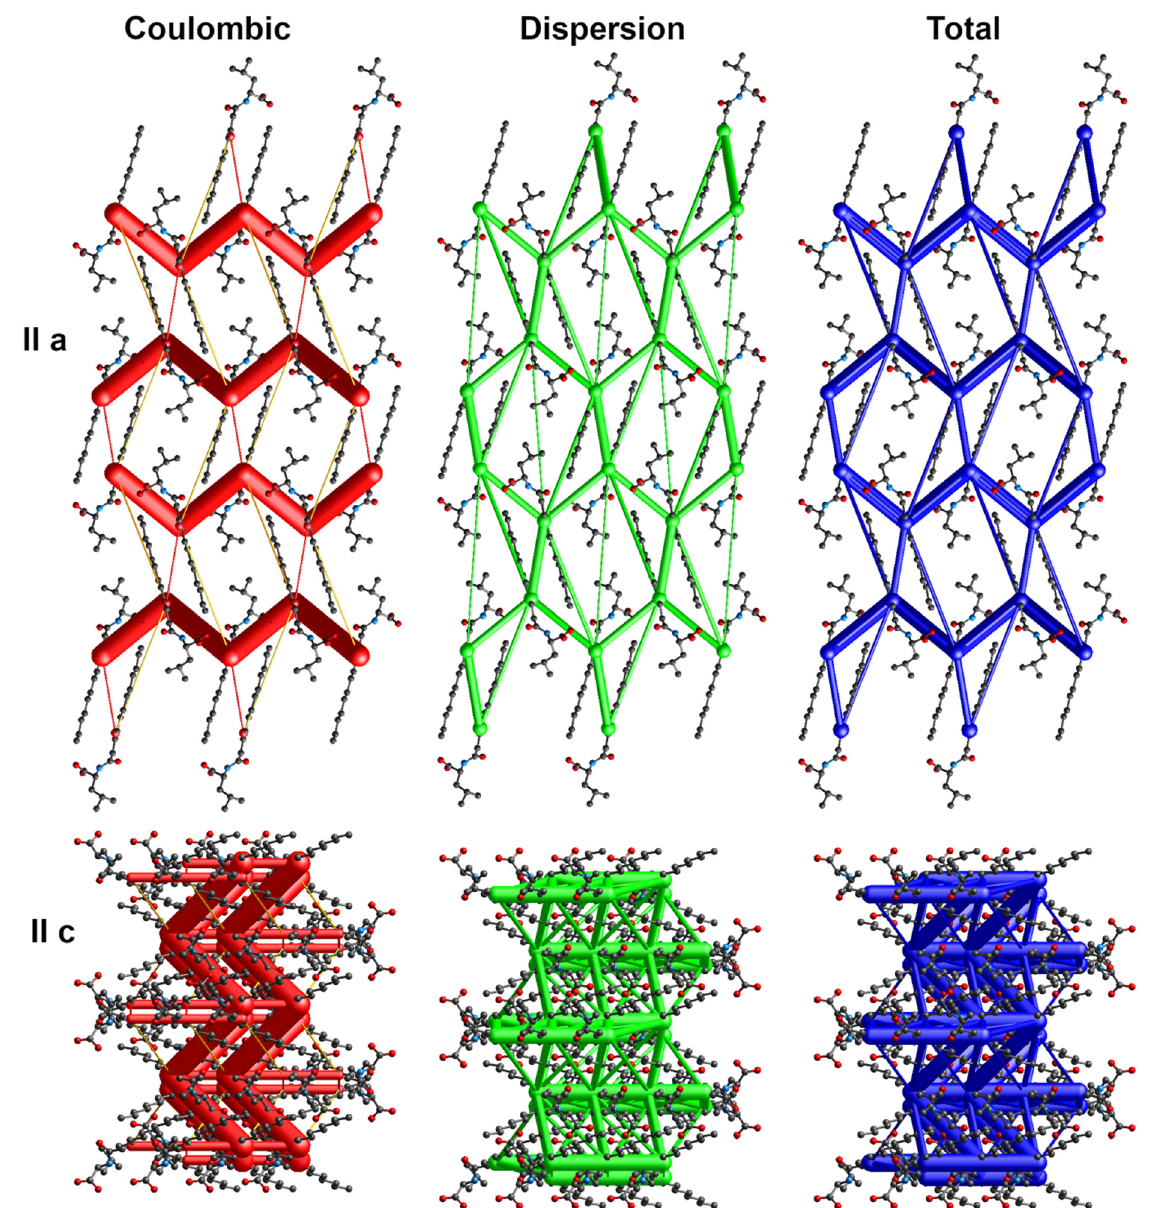
Figure 6. Energy frameworks for 4-Leu. View along a and c directions. Various colors represent various energy terms: red—coulombic, yellow—polarization, green—dispersion, and blue—total energy. The applied scale for tube size 150, the energy cut-off 5 kJ/mol.